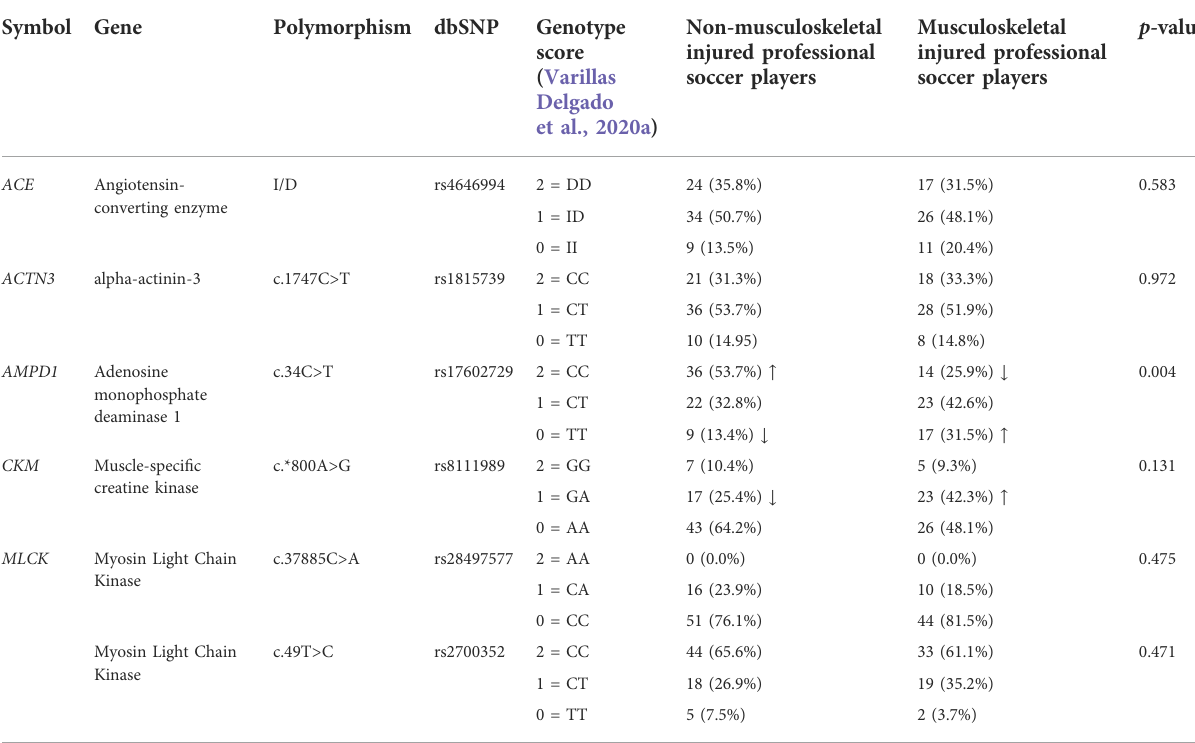
TABLE 6 Genotype distribution in professional soccer players with non-musculoskeletal and musculoskeletal injuries for muscle injuries polygenic pro fi le. Symbol